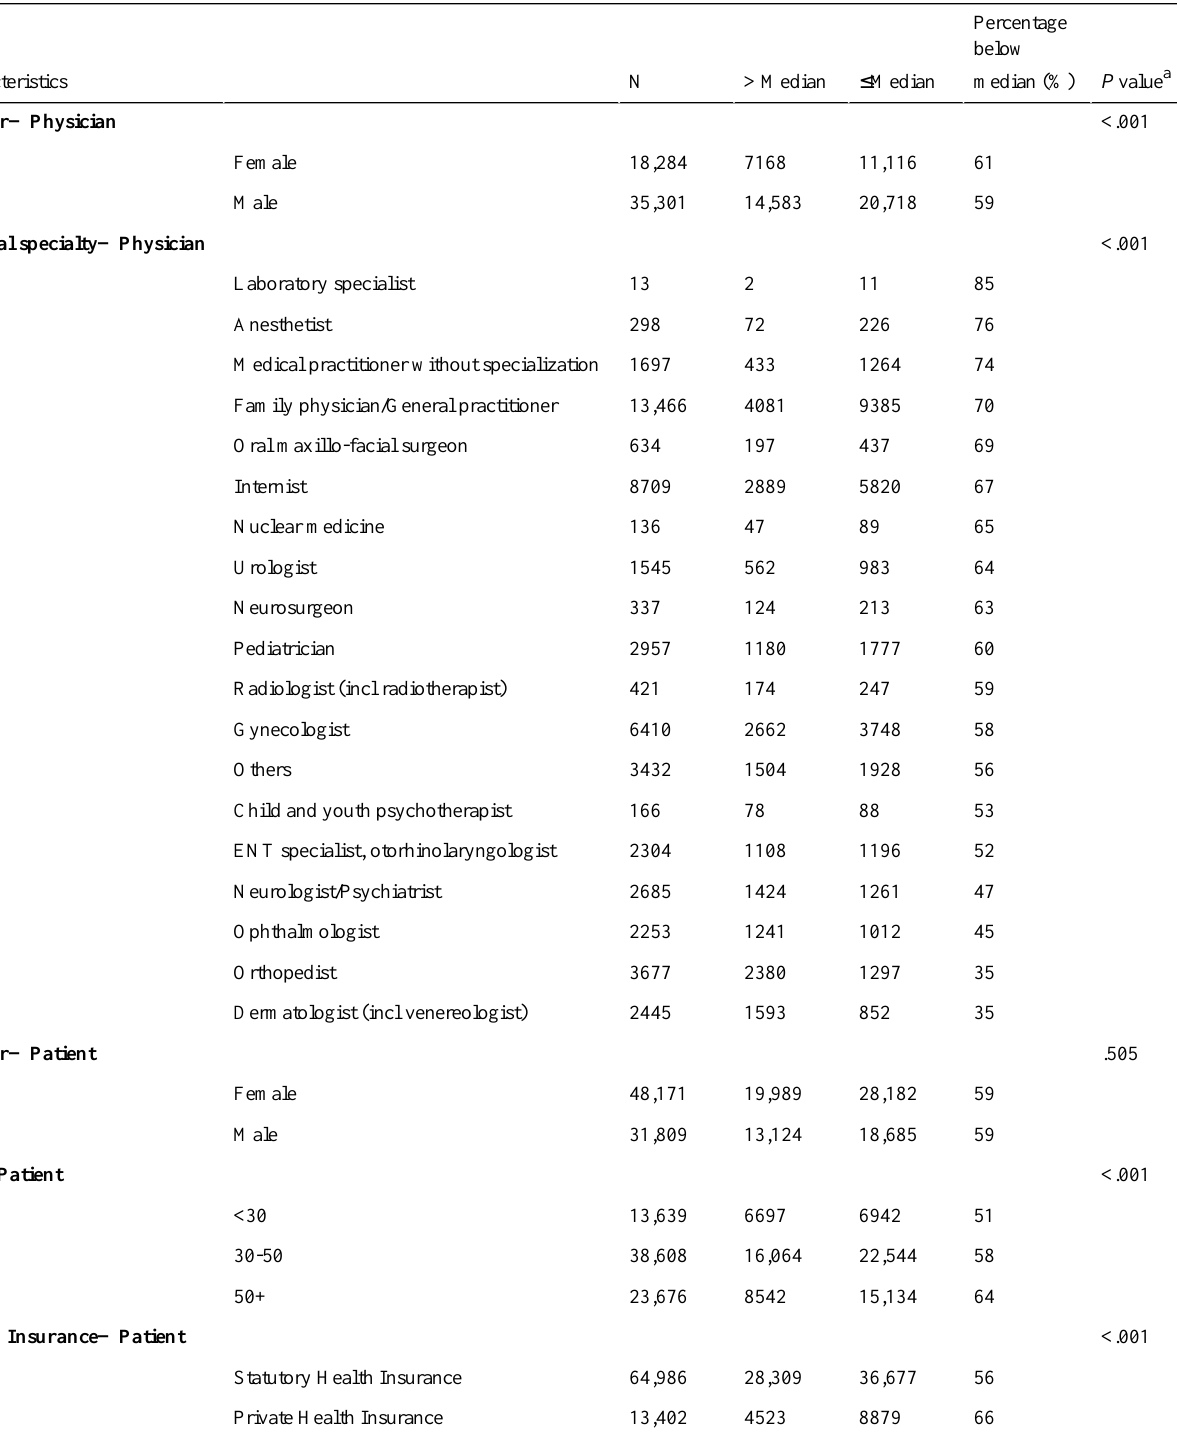
Table 5. Ratings differences regarding physician and patient